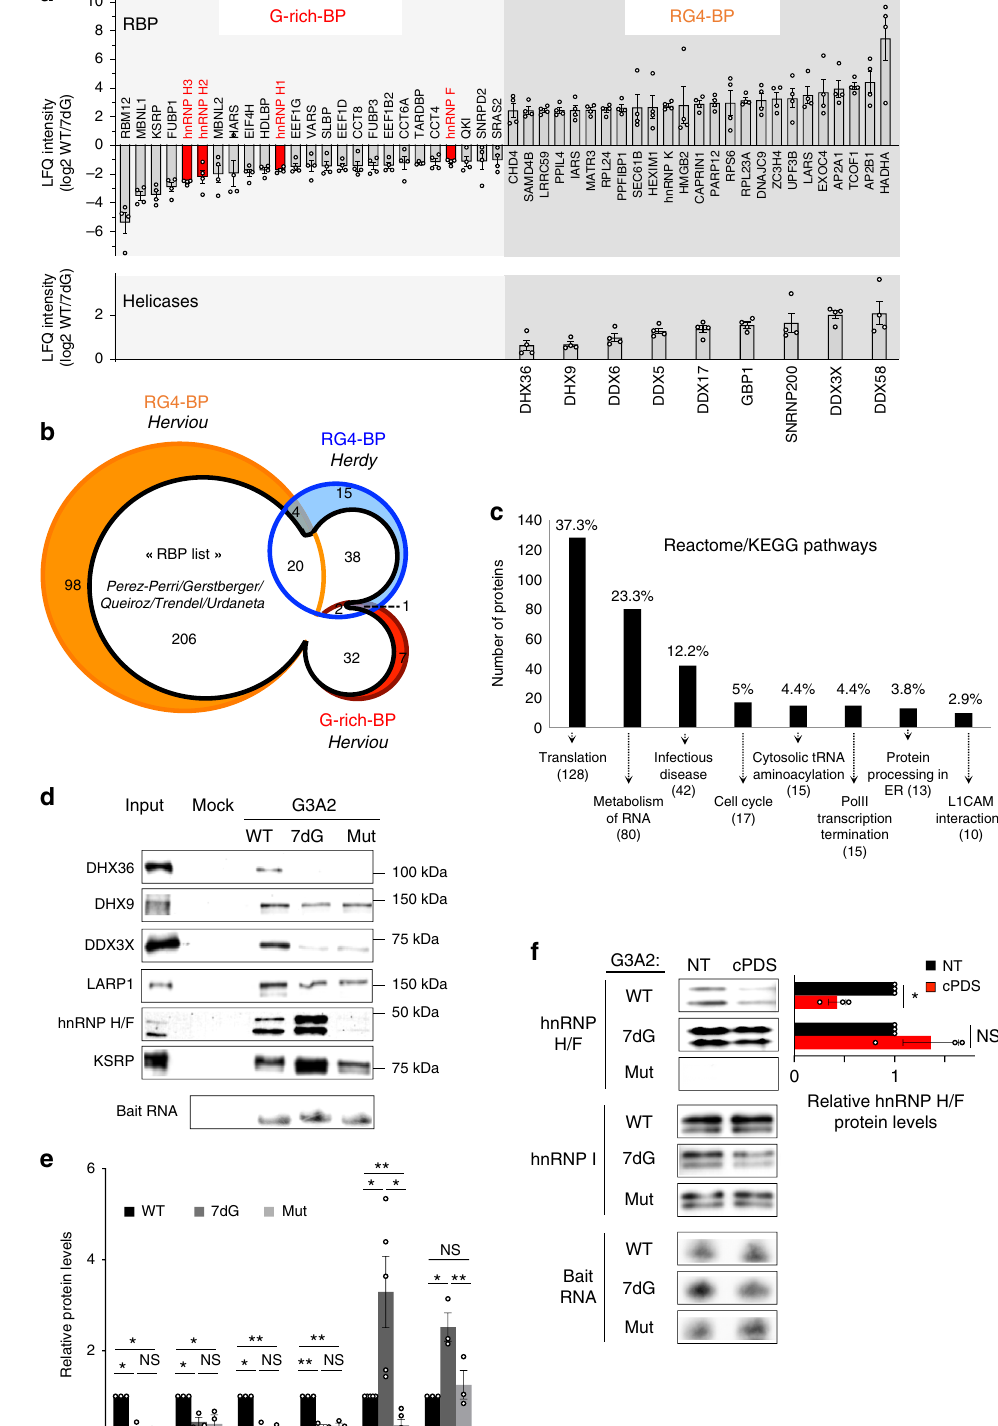
among the RG4-binders, highlighting a possible interplay between RG4s and epitranscriptomic modi fi cations of RNAs 23 . To con fi rm the RP-MS results and further validate preferential binding to the RG4 sequence or structure, RNA pull-down experiments were repeated by incubating cytoplasmic extracts